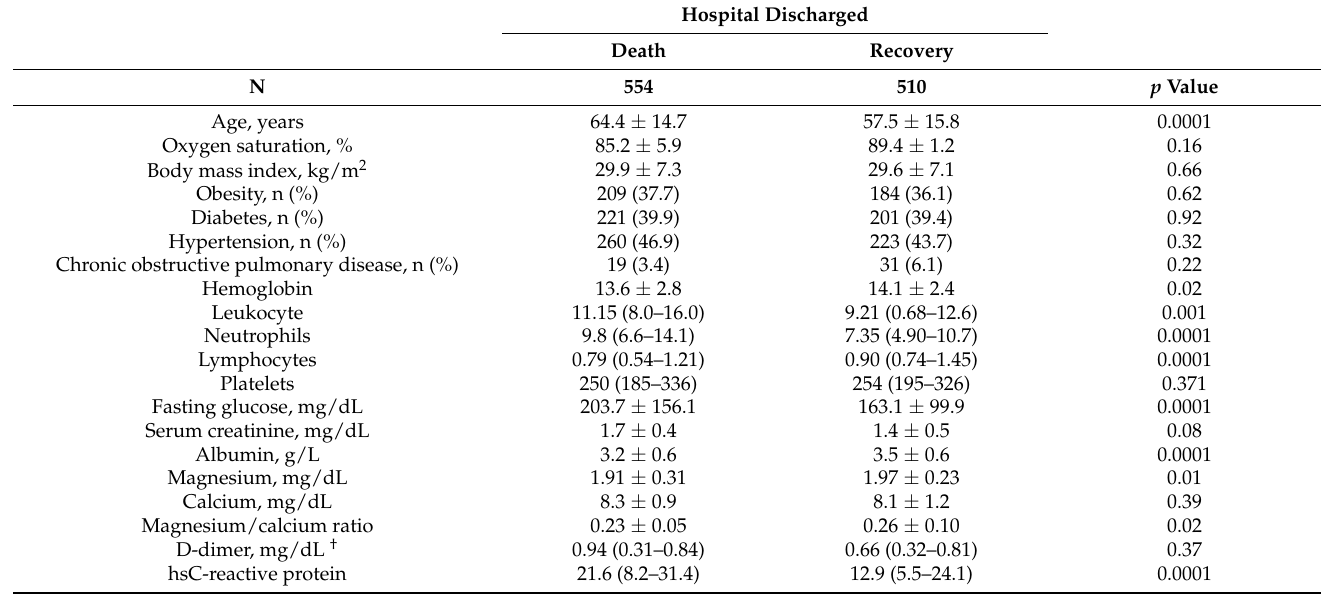
Table 1. Clinical and biochemical characteristics of the target population, N = 1064.